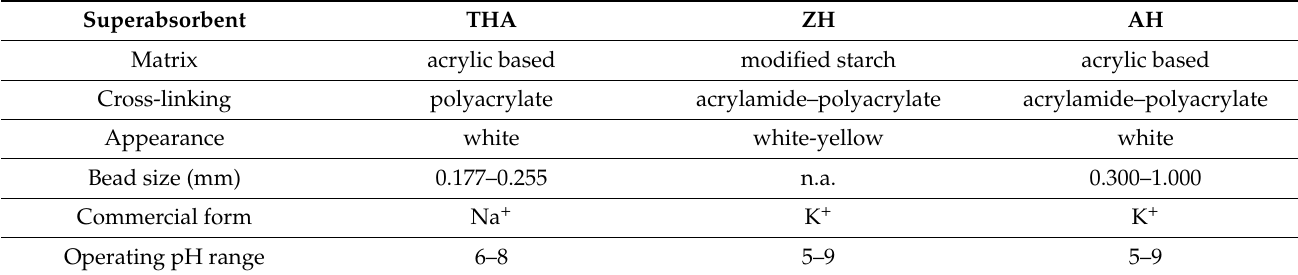
Table 1. The physicochemical properties of THA, ZH and AH hydrogels.